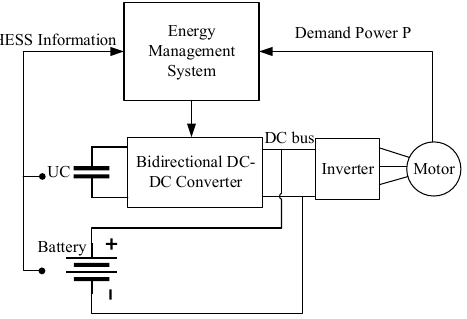
Figure 1. The UC semi-active topology of the HESS.